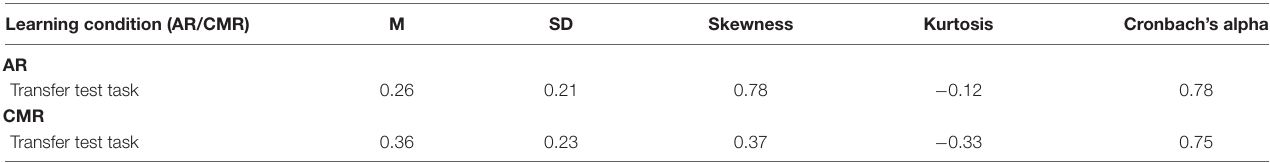
TABLE 3A | Mean proportion correct response ( M ) and standard deviations ( SD ), skewness, kurtosis and Cronbach’s alpha for the AR and CMR learning conditions, respectively. Learning condition (AR/CMR) M SD